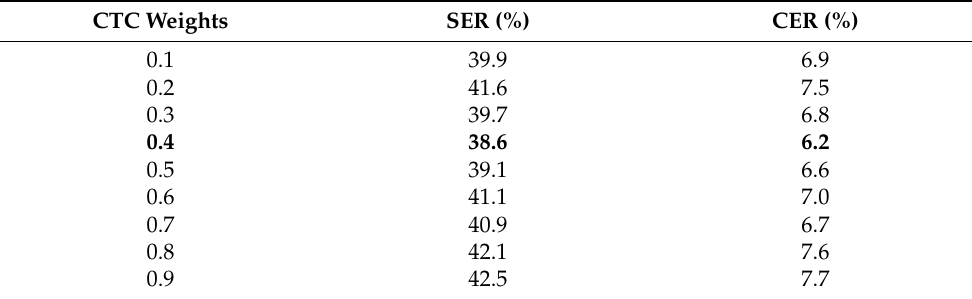
Table 2. Different CTC weights for Conformer